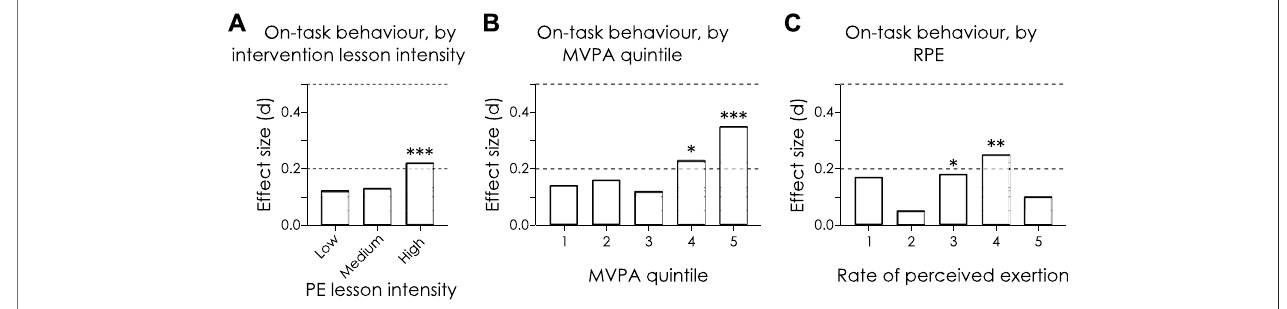
FIGURE2| Changeinon-taskbehaviourinresponsetophysicalactivityintensity. (A) On-taskbehaviour,byinterventionlessonintensity (B) On-taskbehaviour,by MVPA quintile (C) On-task behaviour, RPE. Note. MVPA (cid:1) Moderate-to-vigorous physical activity. Small ( d (cid:1) 0.2), medium ( d (cid:1) 0.5), and large ( d (cid:1) 0.8) effect sizes are indicated by the dashed grid lines. * p ≤ 0.05, ** p ≤ 0.01, and *** p ≤ 0.001.